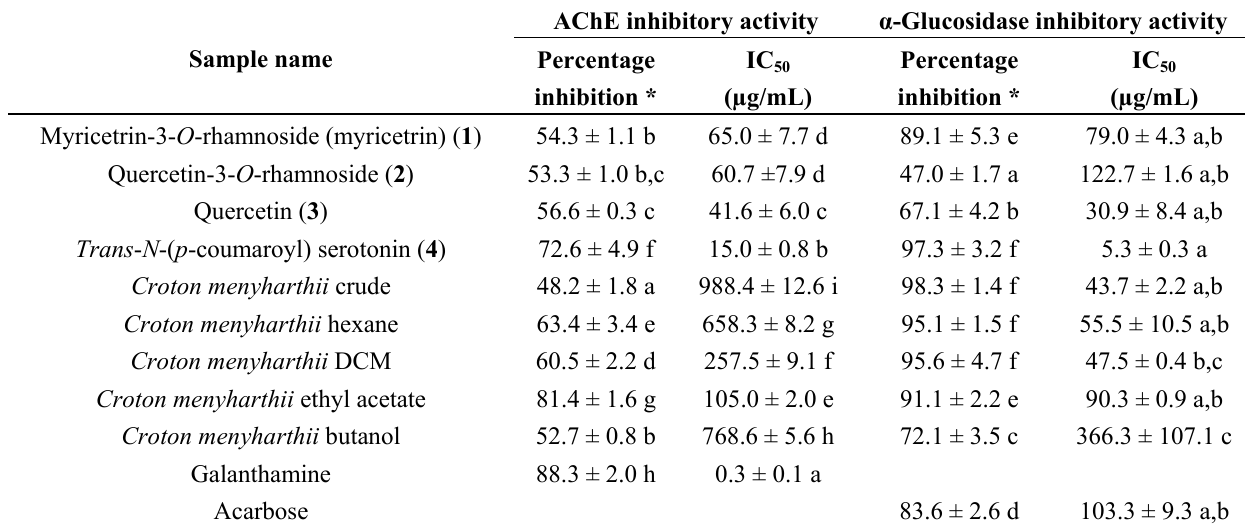
Table 2. AChE and α -glucosidase inhibitory activity (IC fractions and four compounds isolated from Croton menyharthii leaf methanol